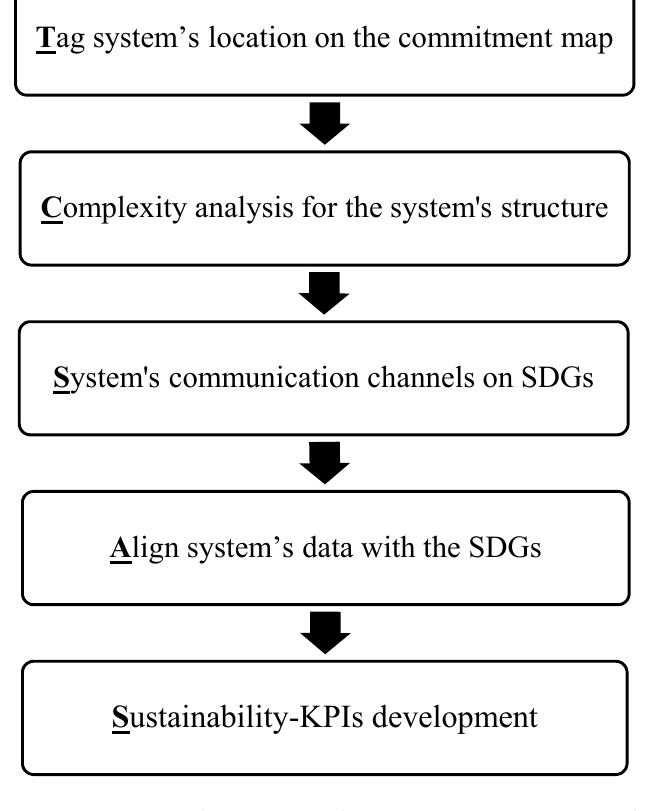
Figure 3. Framework to gain insight on SDG integration into value chains (TCSAS). Step 6: Verify and